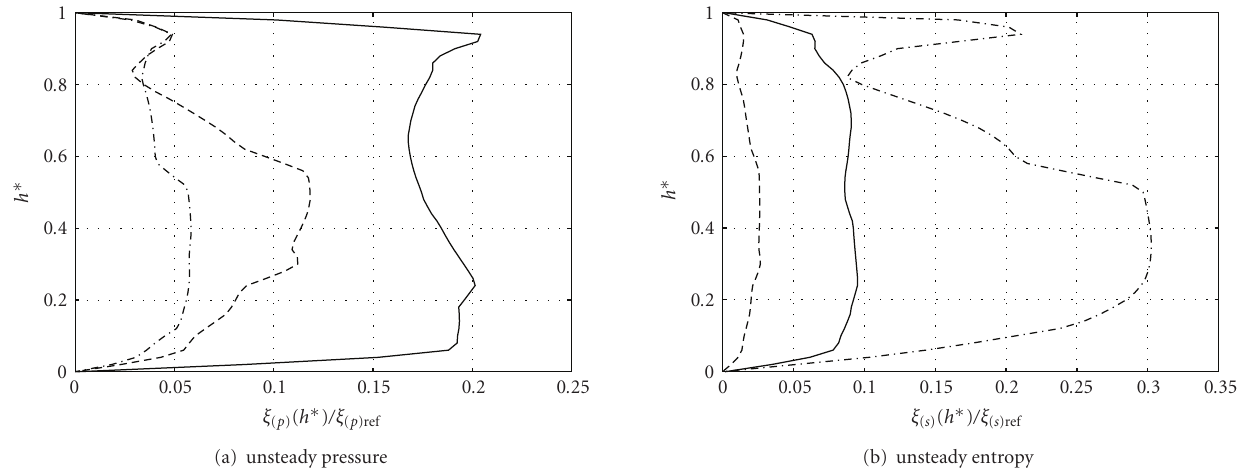
Figure 15: Hub-to-shroud evolution of the spinning modes energy according to their type of transport, at mid inter row gap.